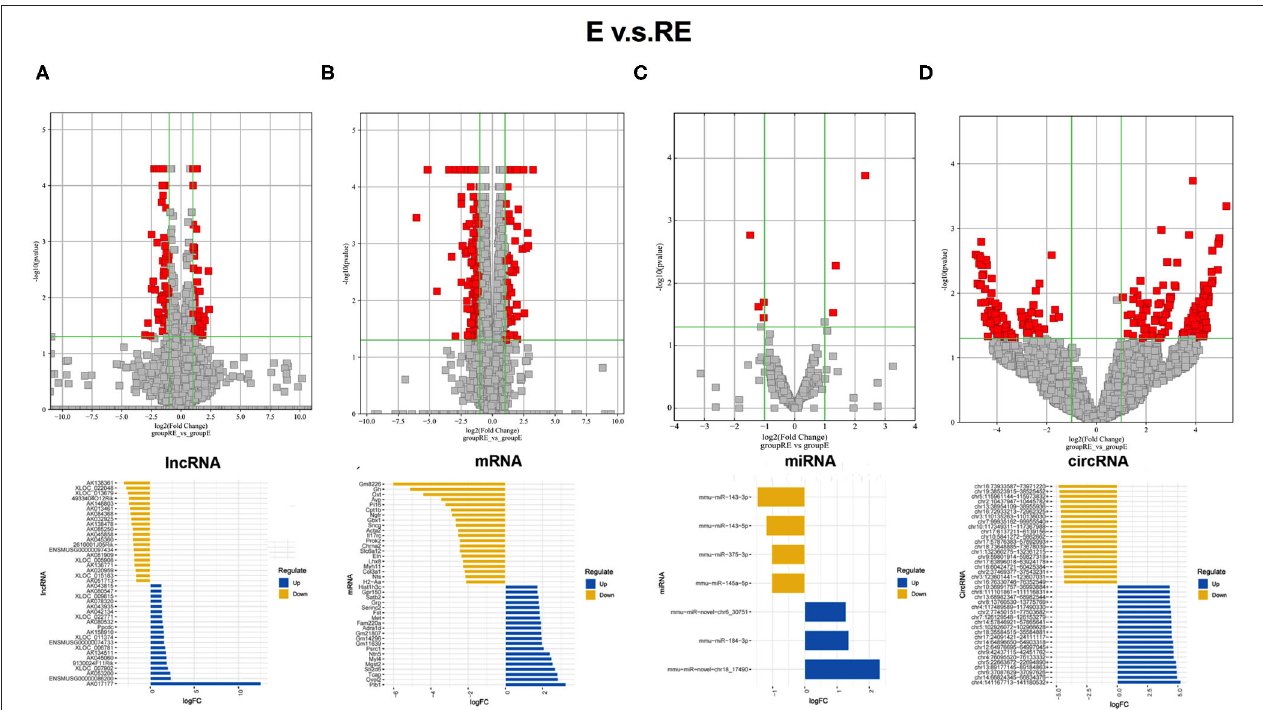
FIGURE 3 | Different changed RNAs between E and RE groups. (A) In the volcano plots, red and gray points represented abnormal lncRNAs and non-significantly differentially expressed lncRNAs, respectively, when E compared with the RE group. The top 20 upregulated genes (blue) and the top 20 downregulated (yellow) genes were presented. Expression profiles were similarly shown for mRNA (B) , miRNA (C) , and circRNA (D) . E, fear memory extinction group. RE, retrieval-extinction group. circRNA, circular RNA; lncRNAs, long non-coding